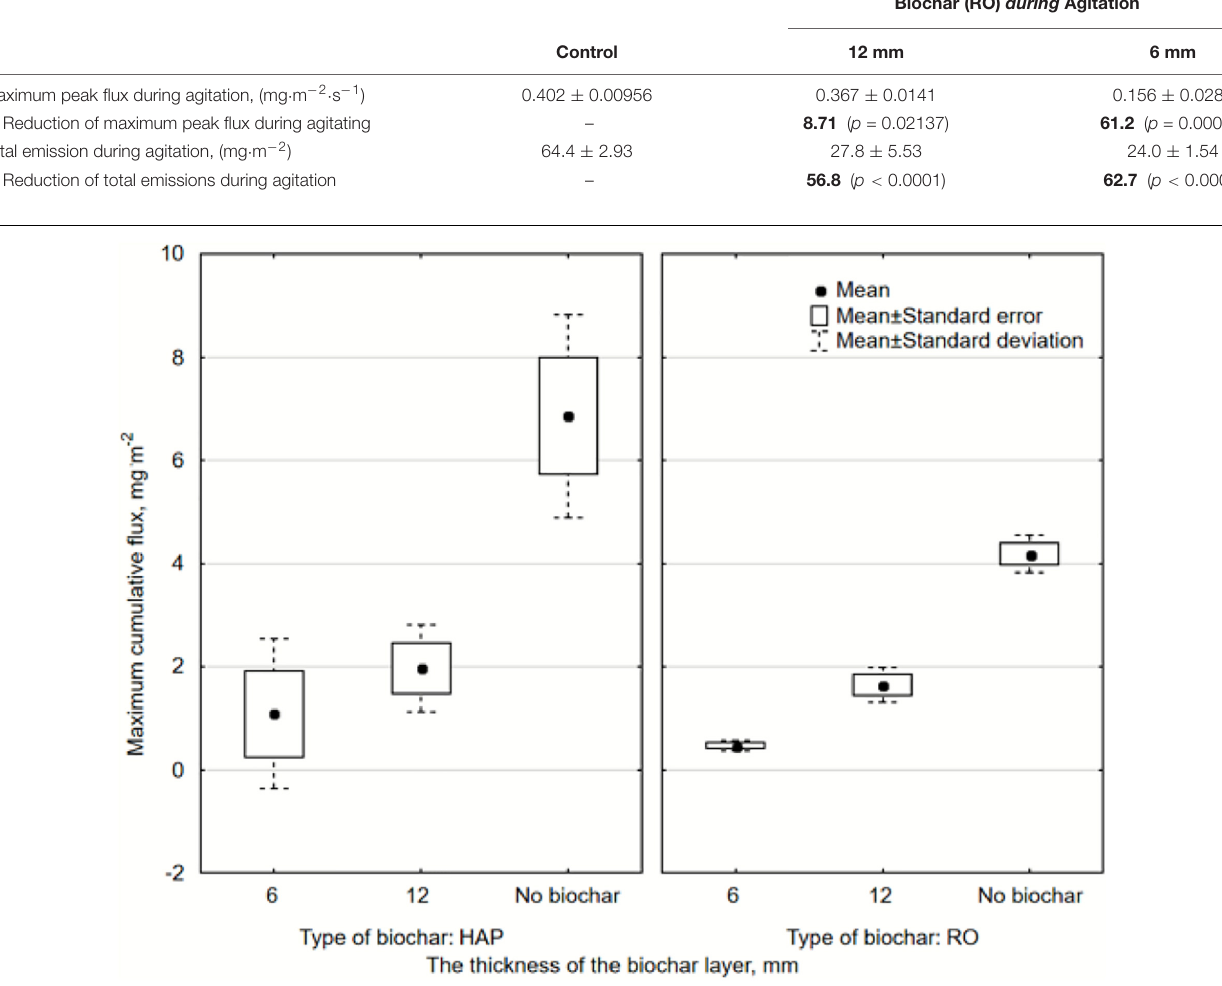
Biochar (RO) during Agitation